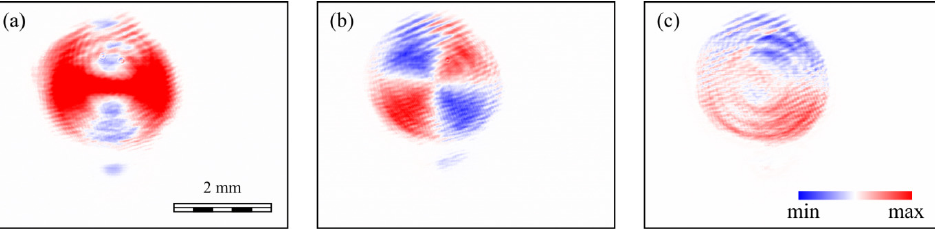
Figure 12. The intensity distribution of the beam from Equation (47) at m = 1 registered by the camera.